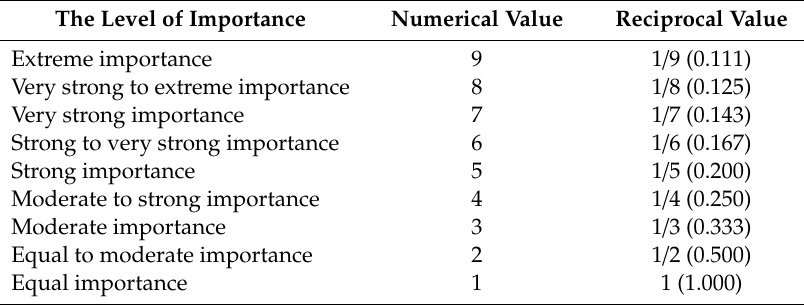
Table 1. Analytic hierarchy process (AHP) scale of